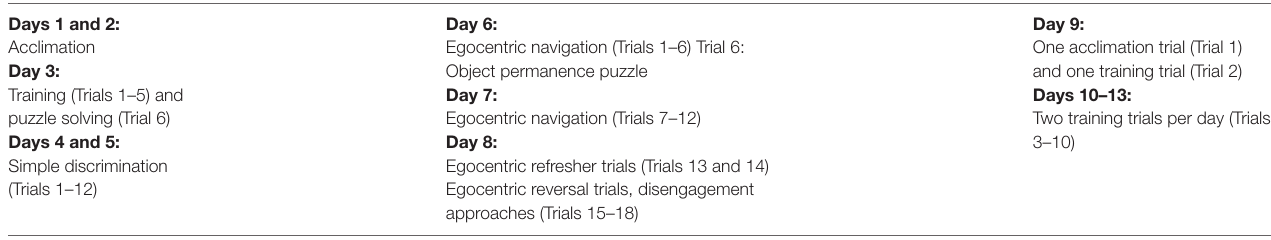
TABLE 1 | Cognitive tests were administered in three apparatus over a 17 day period.